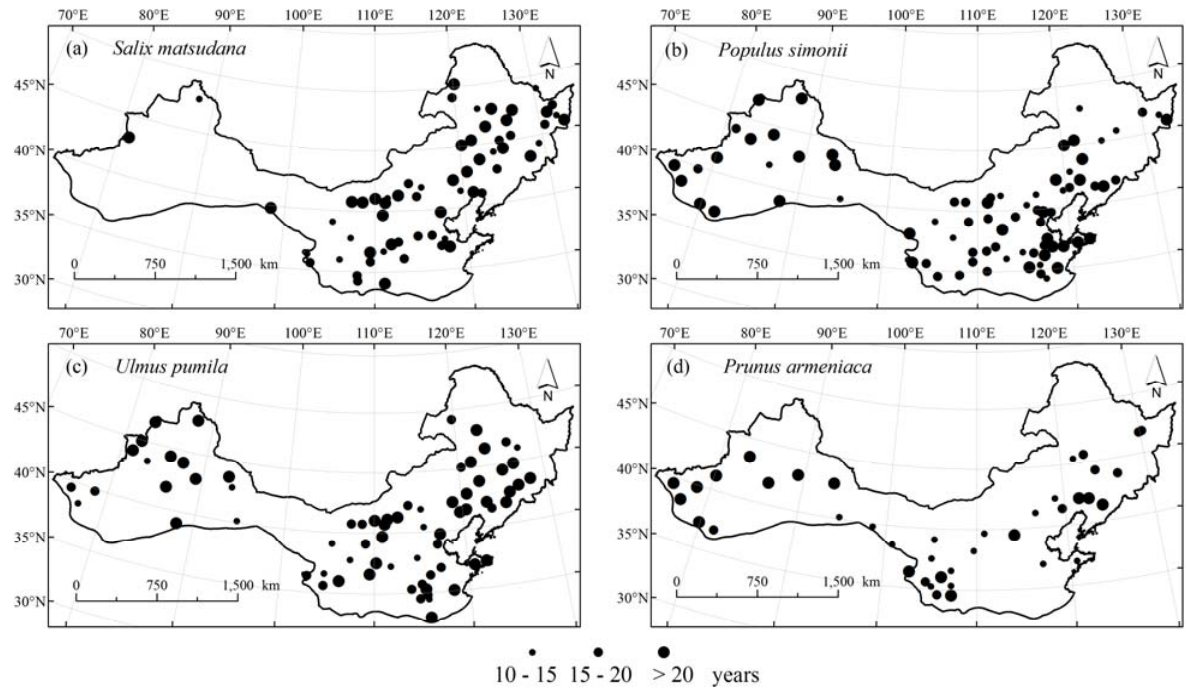
Figure 2. Distribution of phenological stations and time series length of leaf unfolding data for the four tree